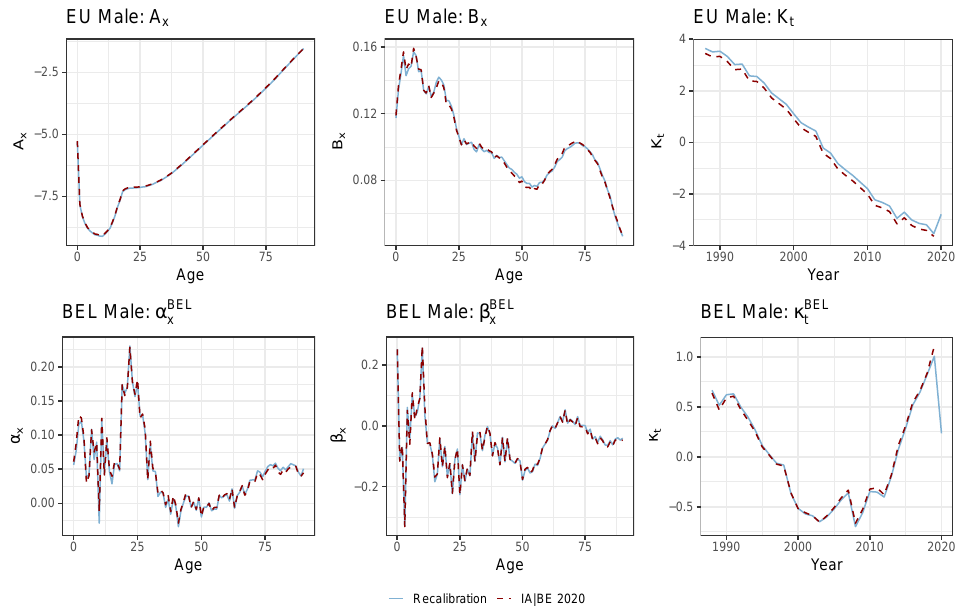
Figure 6. The European and Belgium-specific Li and Lee parameters ˆ A x , ˆ B x , ˆ α x , ˆ β x , ˆ K t and ˆ κ t for males. The blue line corresponds to the Li and Lee model calibrated on data from the years 1988–2020, with virtually created deaths and exposures for the years 2019–2020. The dark red, dashed line shows the calibrated Li and Lee parameters in the original IA | BE 2020 model (calibration period 1988–2018(9)).